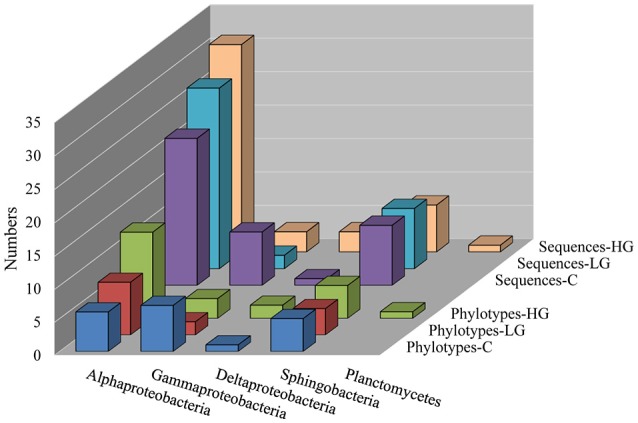
Effects of glyphosate on bacterial community in P. donghaiense cultures. The bacterial richness (numbers of phylotypes) and abundance (numbers of sequences) in five main groups Alphaproteobacteria, Gammaproteobacteria, Deltaproteobacteria, Sphingobacteria, and Planctomycetes in cultures amended with different concentrations of glyphosate. C, the control, f/2 medium; LG, f/2 medium amended with lower concentration (36 μM) of glyphosate; HG, f/2 medium amended with higher concentration of glyphosate (360 μM).